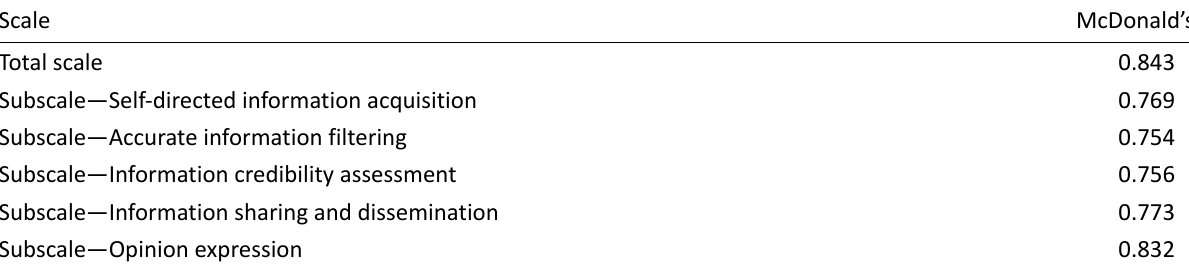
Table 1. McDonald’s 𝜔 coefficients for scientific information literacy scale. Scale